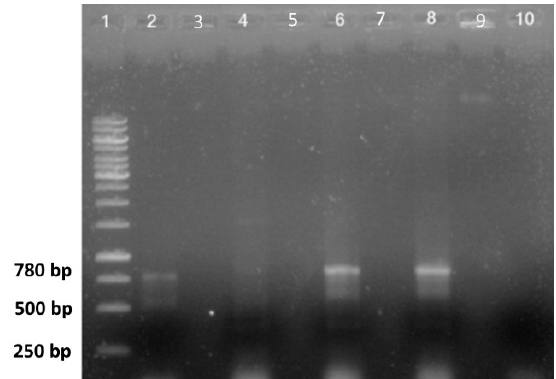
Figure 4. PCR amplification products of the rol B gen: lane (1) 1 Kb marker; lane (2) total DNA from A. rhizogenes ATCC 15834/pTDT strain; lane (3) empty; lane (4) total DNA from a wild type seedling L. racemosa ; lane (5) empty; lane (6) total DNA of regenerated plantlet LRT 2.3; lane (7) empty; lane (8) total DNA of regenerated plantlet LRT 6.4; lane (9) empty and lane (10) negative control